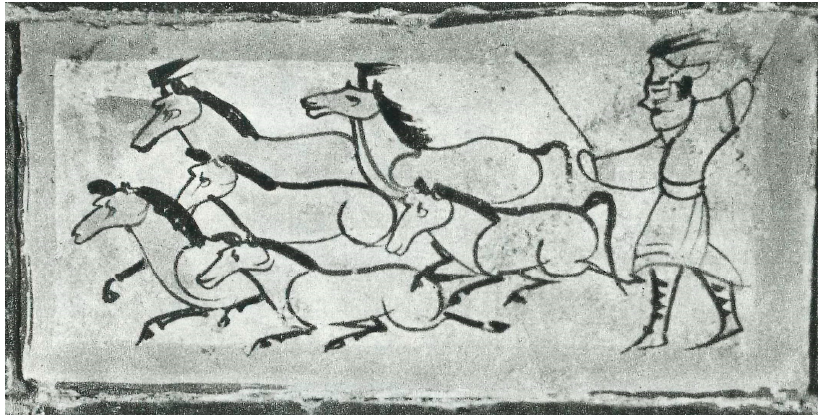
Figure 7. Sogdian horse herder, north wall of front chamber, Xincheng M6, painting on brick, Wei- Jin period (220–317). (Gansusheng Bowuguan et al. 1985, pl. 53.1). ©Wenwu Press. This figure published with permission of Wenwu Press and cannot be used or copied without their